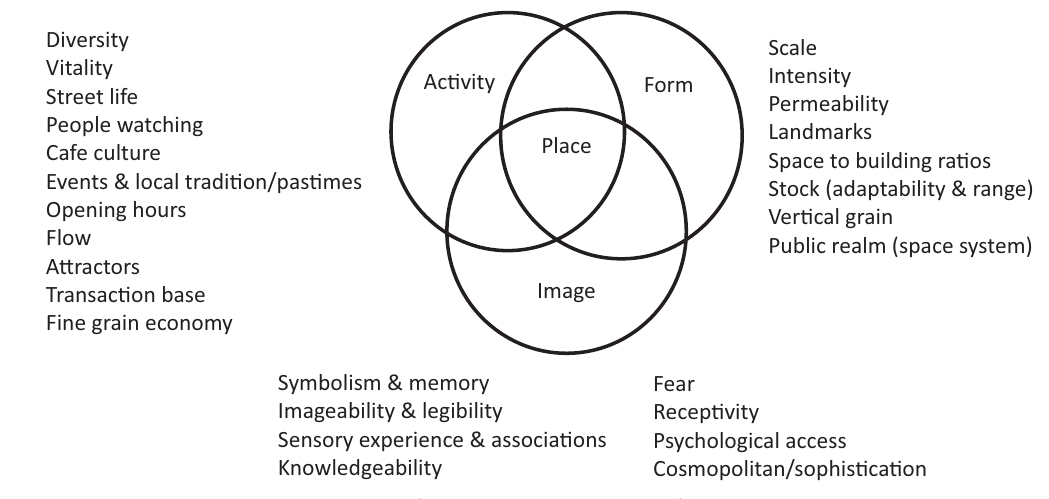
Figure 5. Policy direction to foster place making (Montgomery, 1998, p.